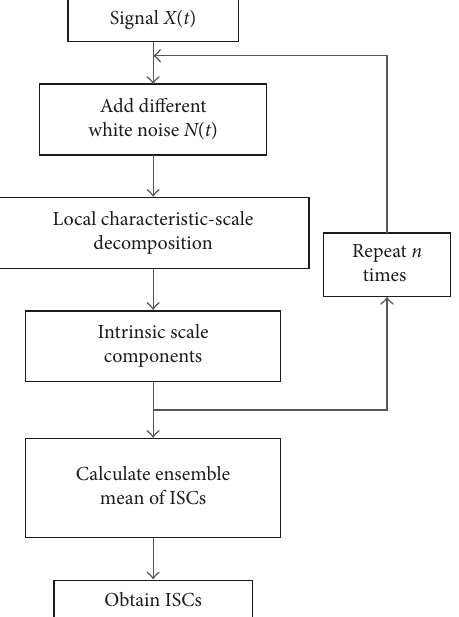
Figure 1: Ensemble local characteristic-scale decomposition algorithm.